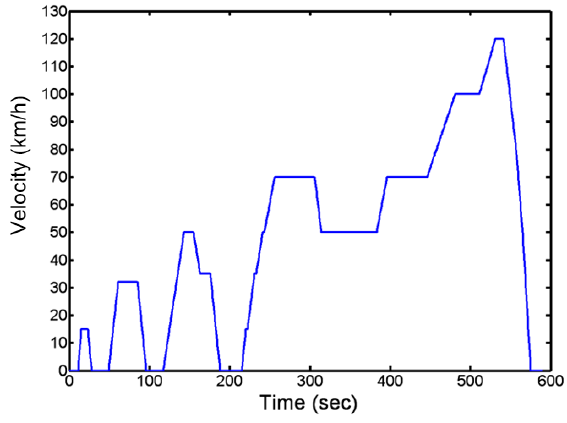
Figure 6. NEDC2000 high-speed driving pattern.